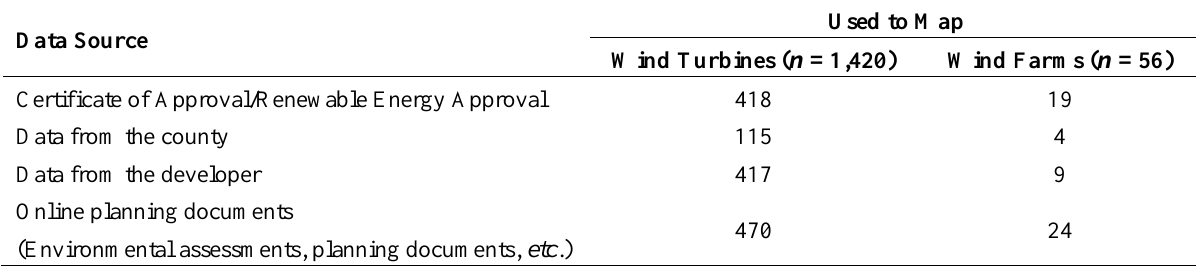
Table 2. Sources for wind turbine spatial